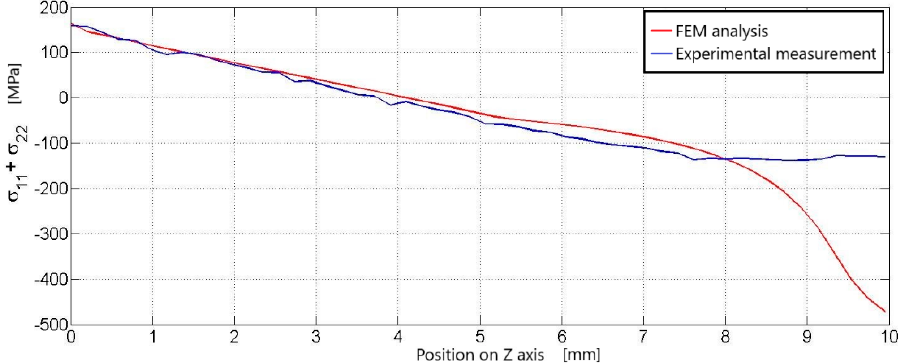
Figure 6. Comparison of the course of principal stresses in experimental measurements with the course of principal stresses in numerical analysis, courses along the black line (Figure 3), compared results for a load of 4 kN.